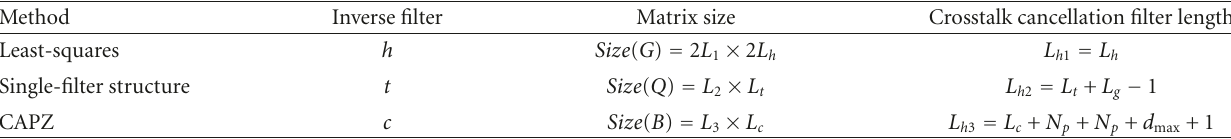
Table 1: Parameters for the three methods: the least-squares method, the single-filter structure method, and the CAPZ method.